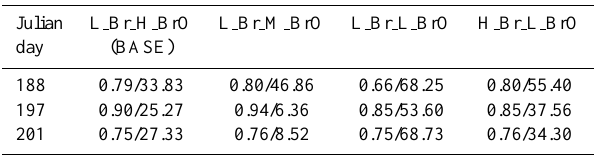
Table 3. Correlation and average error during AMDEs as an in- dicator for simulated GEM agreement with measured GEM during AMDEs.